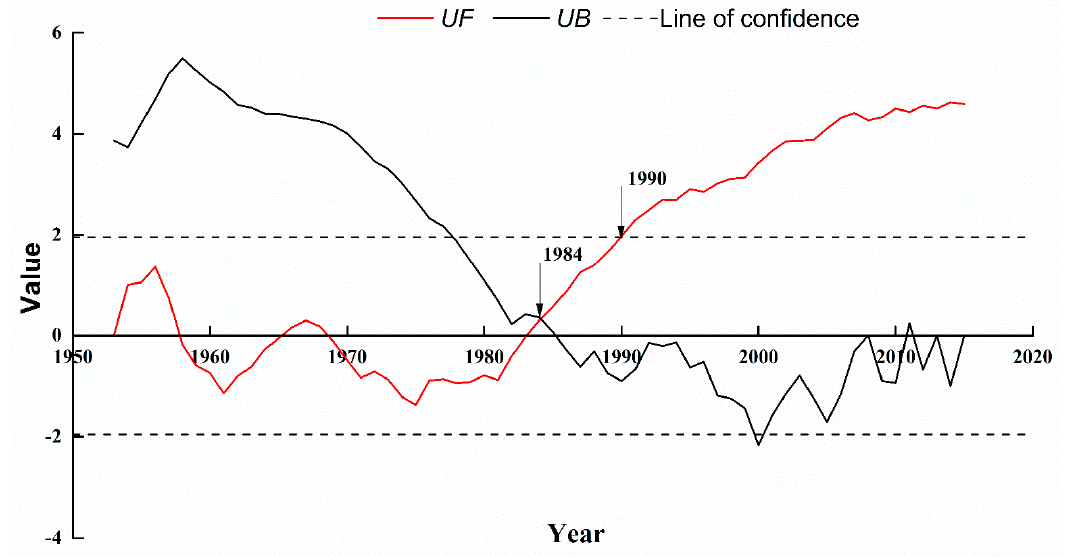
Figure 3. Mann–Kendall test of mean annual precipitation based on rain gauges over the TP from 1954 to 2013.